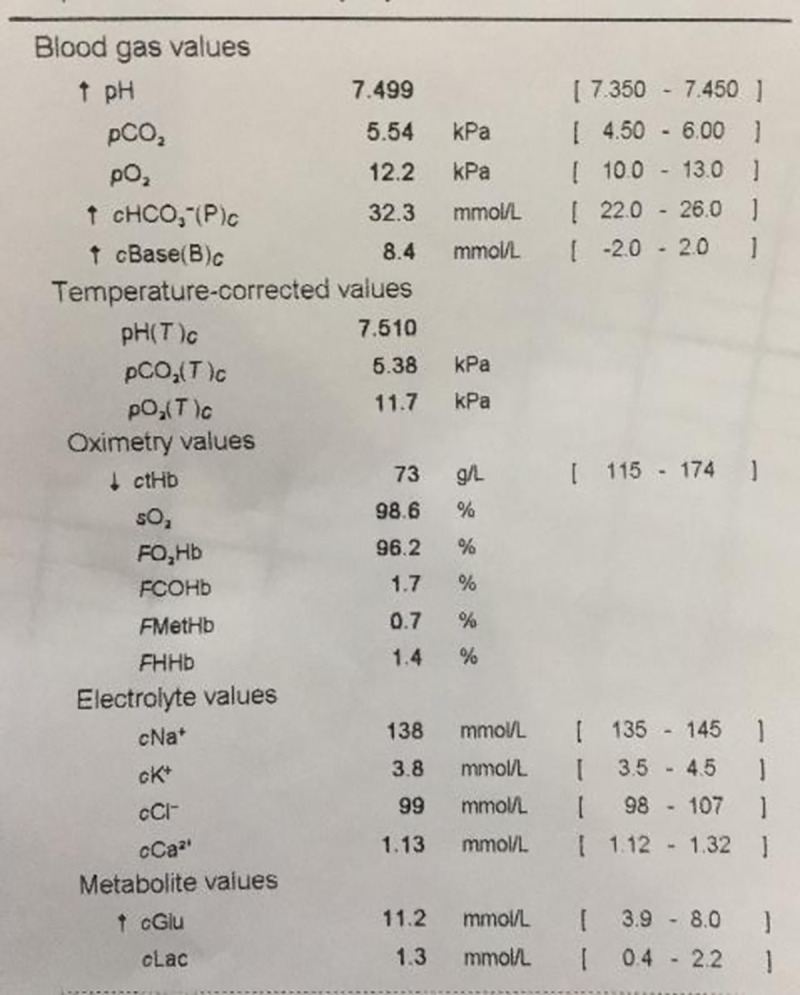
Standard arterial blood gas results from a commercially available analyser.All current analysers, with more or less the same parameters, provide an output in the form of an on-screen or printed analysis which contains raw data, possibly with some standard reference values and indications as to whether the measured values fall inside or outside those reference values.